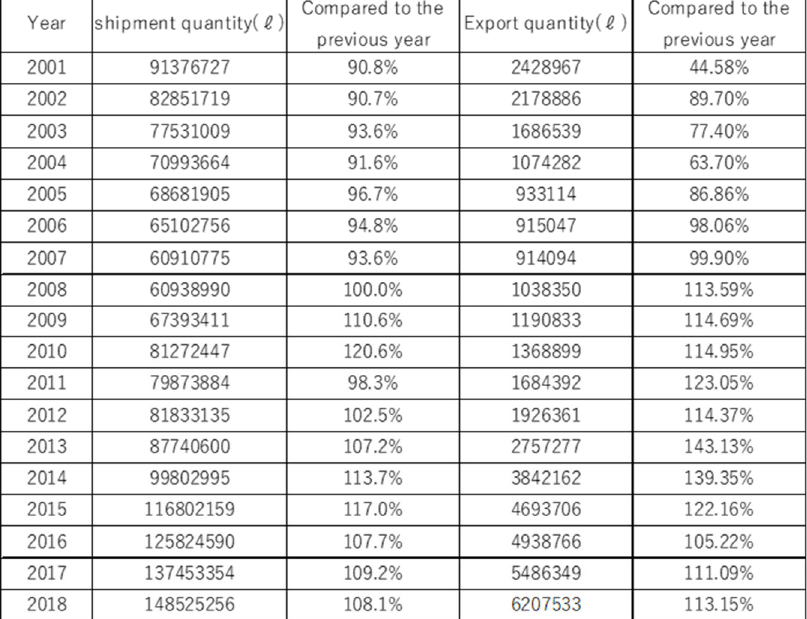
Source: Shipment volumes are from the Western liquor shipments volume survey forms in the statistics by the Japan Spirits & Liqueurs Makers Association. Export volumes are from “Trends in Liquor Exports” on the National Tax